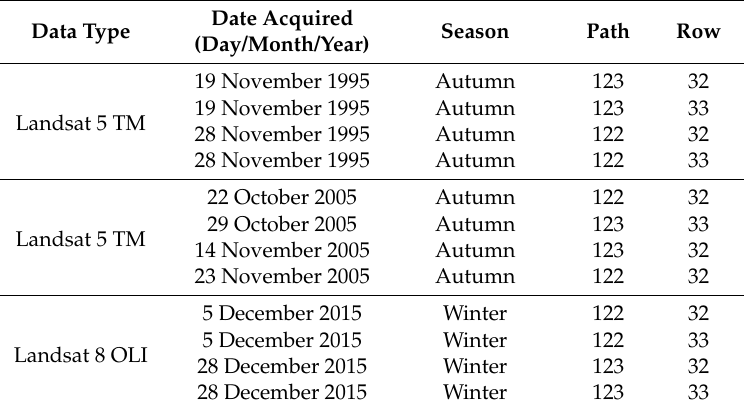
Table 1. Landsat satellite images